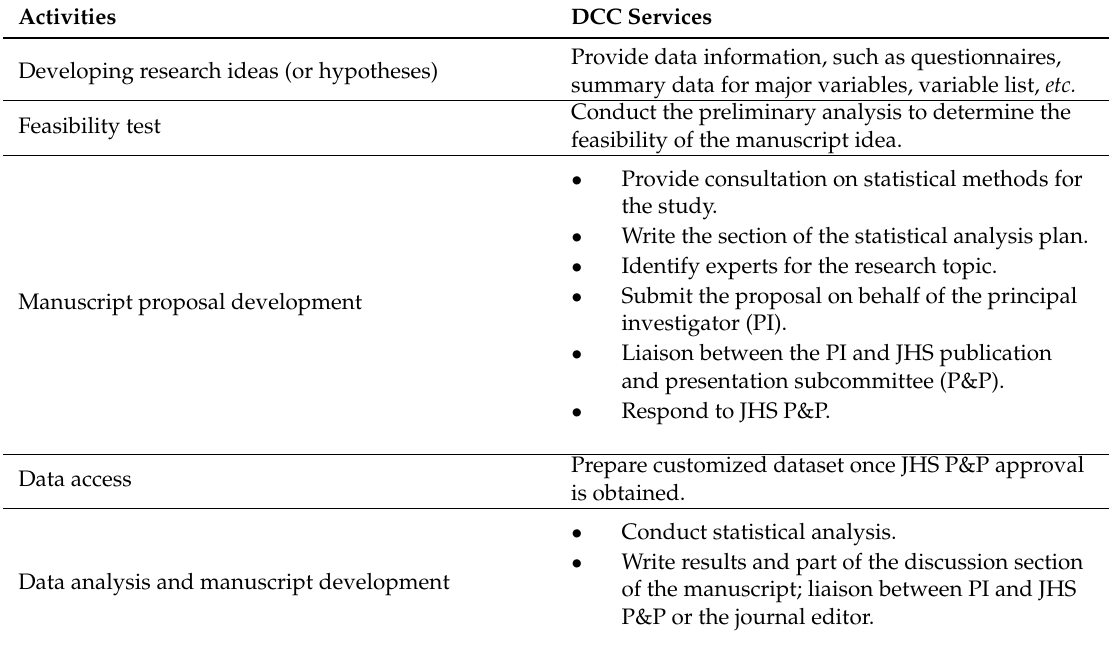
Table 1. Roles of the Data Coordinating Center (DCC) per phase of research